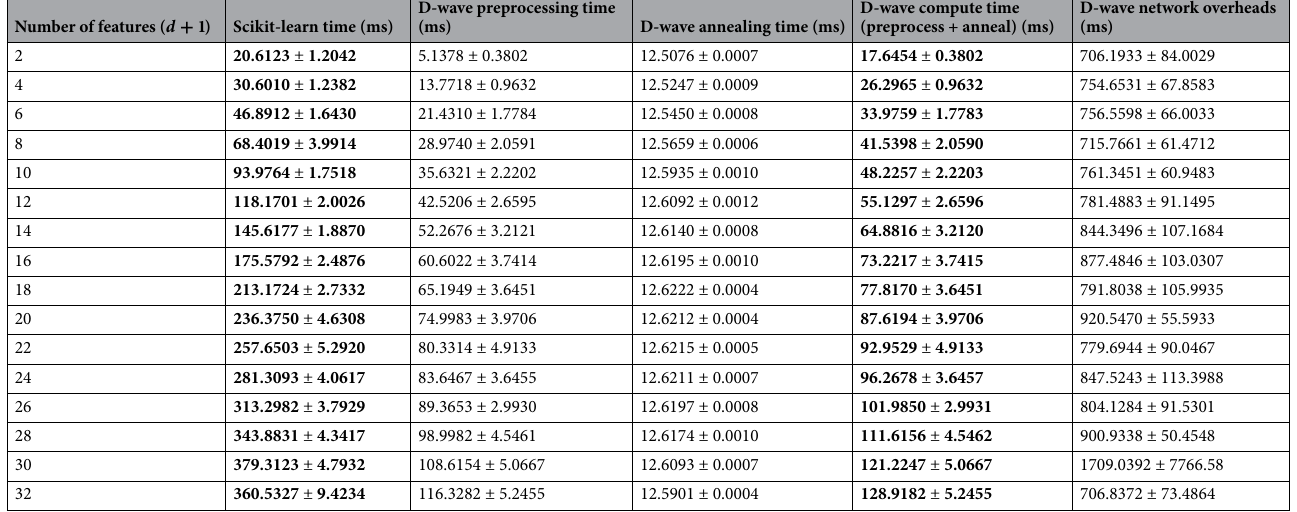
Table 3. Scalability with number of features ( d + 1 ). Significant values are in bold.